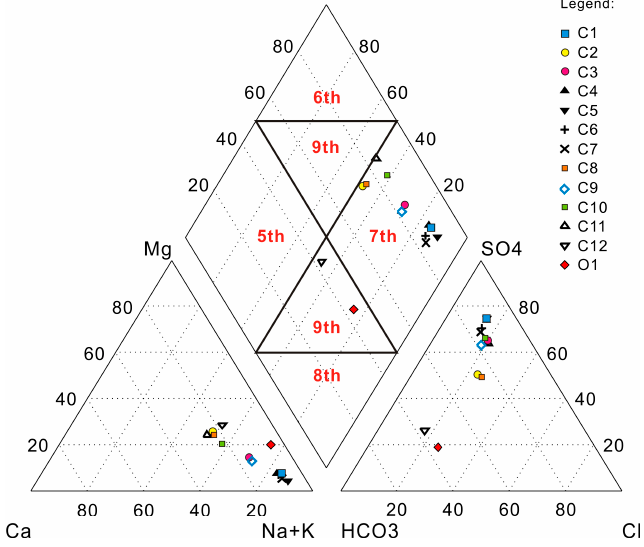
Figure 5. Piper diagram of all groundwater